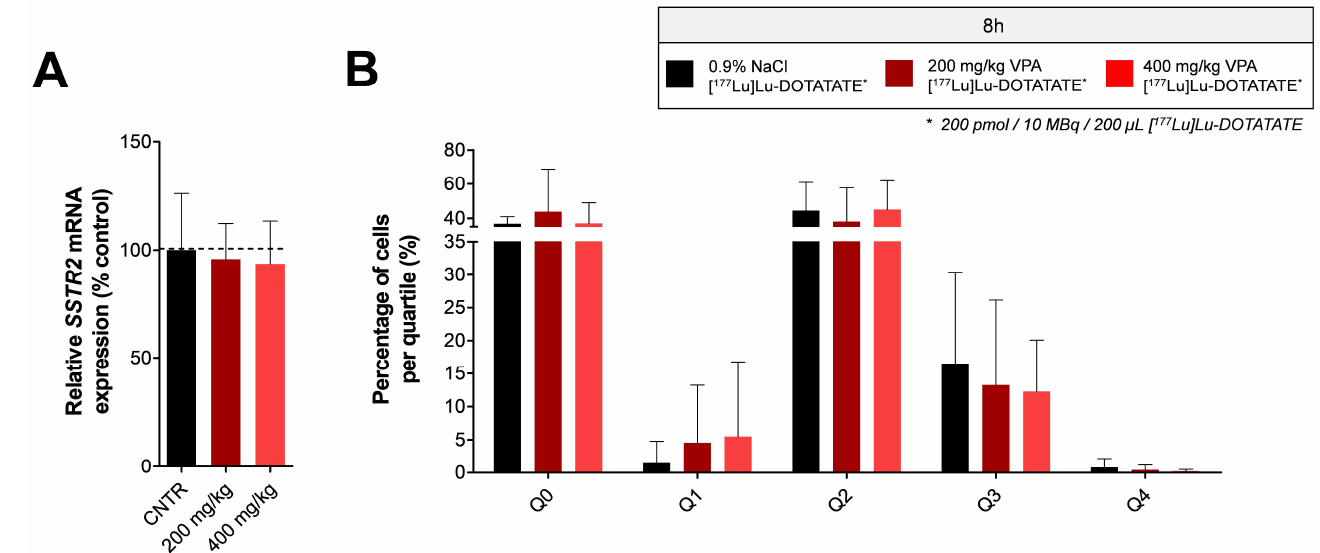
Figure 3. In vivo tumoral SSTR2 expression levels after VPA-treatment Tumors of NCI-H69 tumor-bearing mice injected with vehicle or VPA (200 mg/kg or 400 mg/kg) eight hours prior to [ 177 Lu]Lu-DOTATATE administration were analyzed for SSTR2 mRNA expression levels ( A ) and SSTR2 protein-expression levels ( B ). The percentage of SSTR2 negative cells (Q0) and the extent of SSTR2 intensity (Q1–Q4) were determined ( B